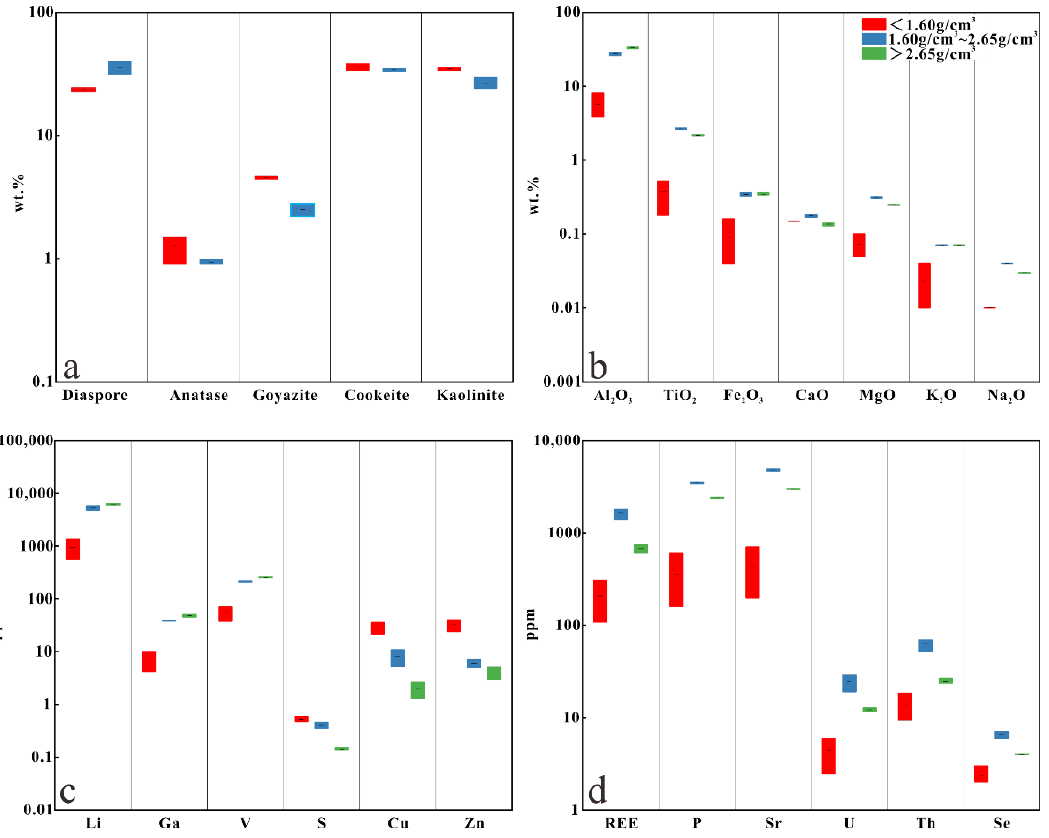
Figure 4. Box-and-whisker plots showing the mineral distribution patterns in the density-fractionated samples ( a ); distribution patterns of major elements in the density-fractionated samples ( b ); distribution patterns of trace element in the density-fractionated samples ( c , d ).